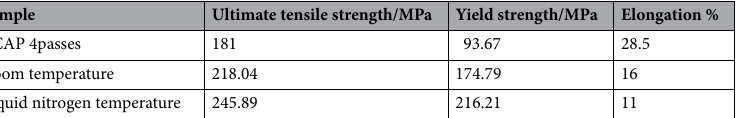
Table 1. Room temperature tensile properties of Mg–2Y–0.6Nd–0.6Zr alloy after ECAP at different rolling